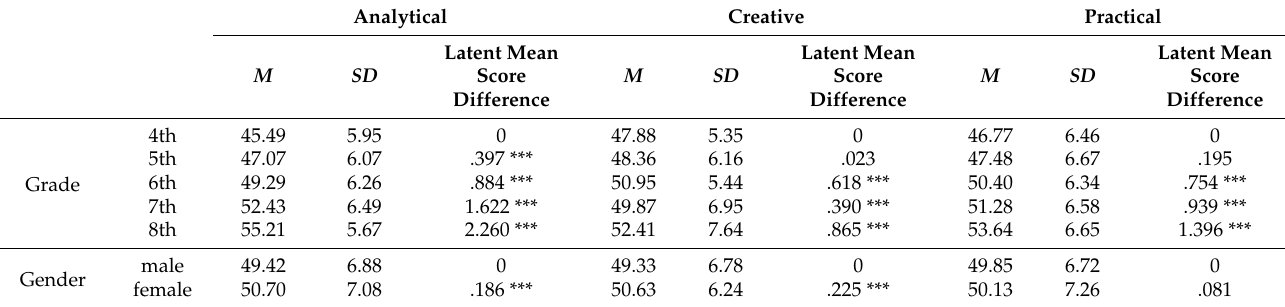
Table 9. Descriptive statistics of Aurora abilities (N =